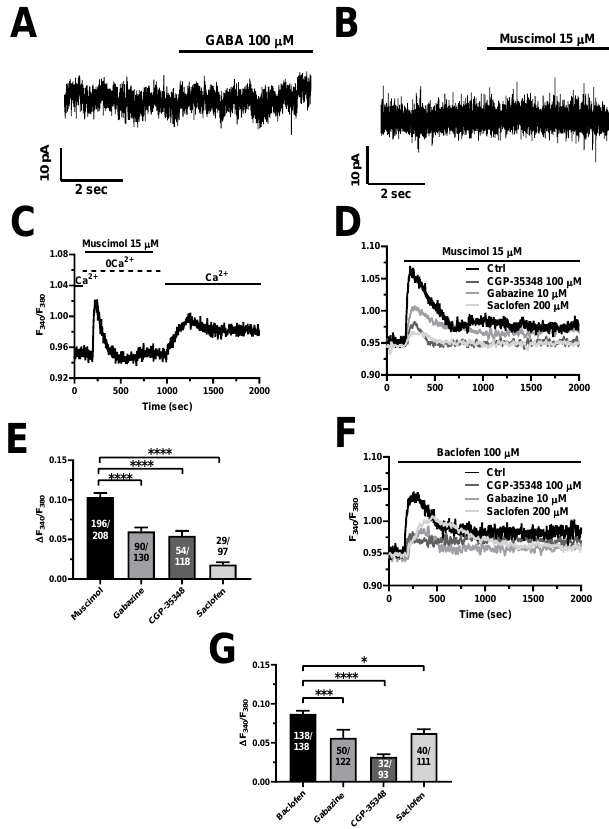
(15 µ M) was significantly inhibited by blocking GABA A receptors with gabazine (10 µ M) (Figure 7D,E). Notably, muscimol-evoked intracellular Ca 2+ signals in hCMEC/D3 cells were also strongly reduced by inhibiting GABA B receptors with either saclofen (200 µ M) or CGP-35348 (100 µ M) (Figure 7D,E). Therefore, GABA A receptors require functional GABA B receptors to signal the increase in [Ca 2+ ] i in a flux-independent manner. Similarly, the Ca 2+ response to baclofen (100 µ M) was sensitive to the pharmacological blockade of either GABA A receptors with gabazine (10 µ M) (Figure 7F,G), or GABA B receptors with saclofen (200 µ M) and CGP-35348 (100 µ M) (Figure 7F,G). Therefore, the sequence of signaling events leading to GABA-induced intracellular Ca 2+ signals in hCMEC/D3 cells requires the functional interaction between both GABA A and GABA B receptors, with GABA A receptors operating in a non-canonical (i.e., flux-independent) manner via GABA B receptors.